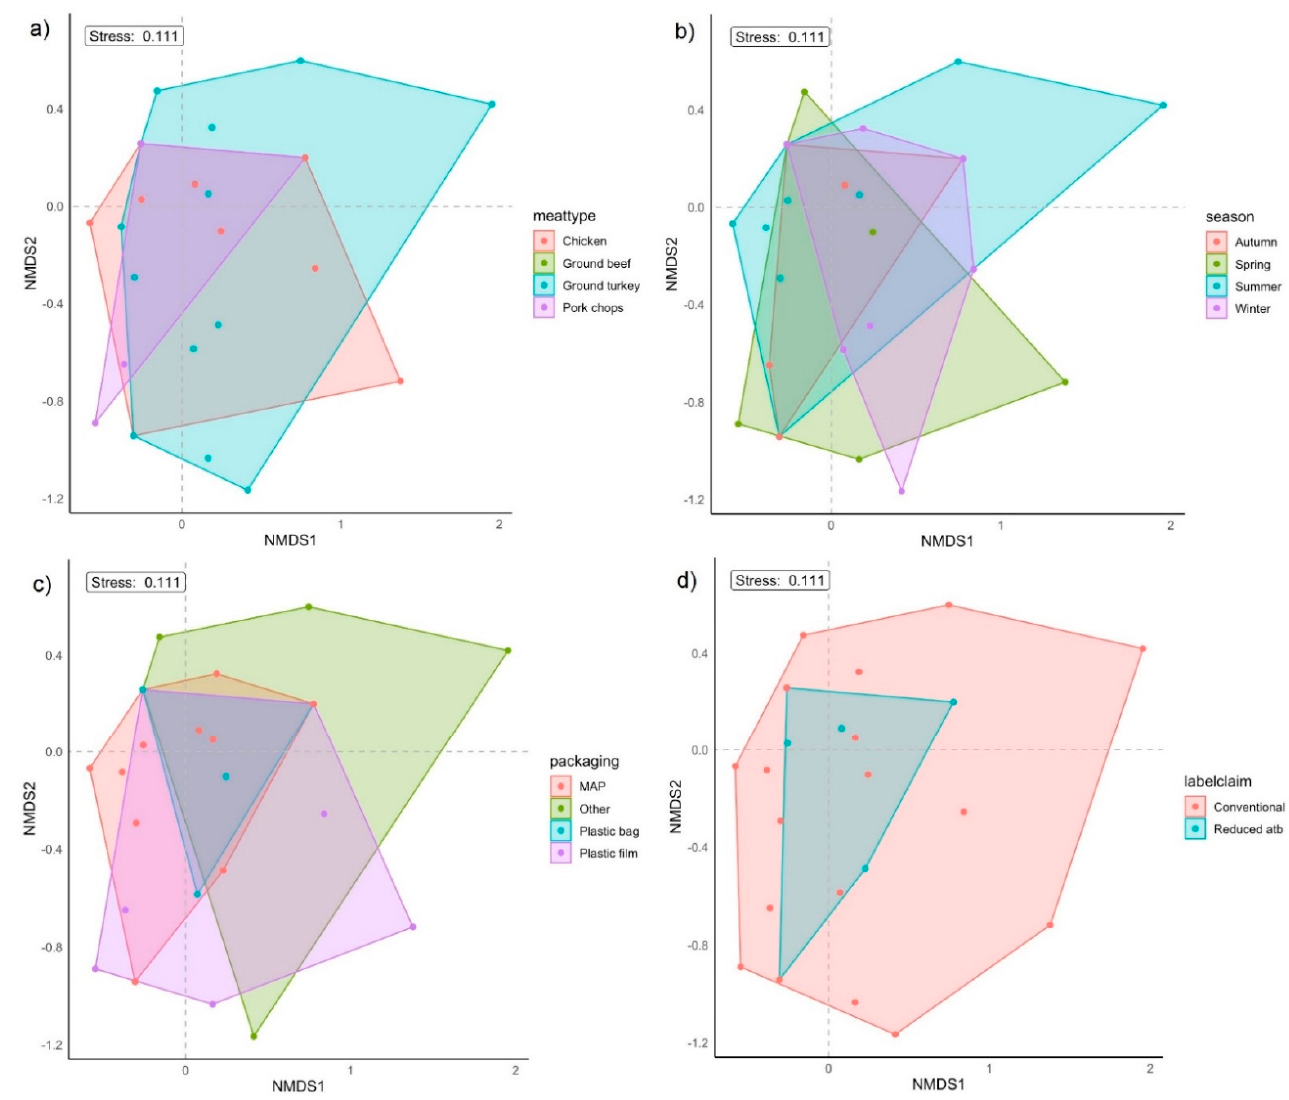
Figure 2. Non-metric multidimensional scaling (NMDS) performed using presence and absence of antimicrobial resistance genes from E. coli isolates from retail meat (n = 52). Individual points represent an isolate, with convex hulls displaying grouping factors of ( a ) meat type; ( b ) season; ( c ) packaging type; and ( d ) label claim.